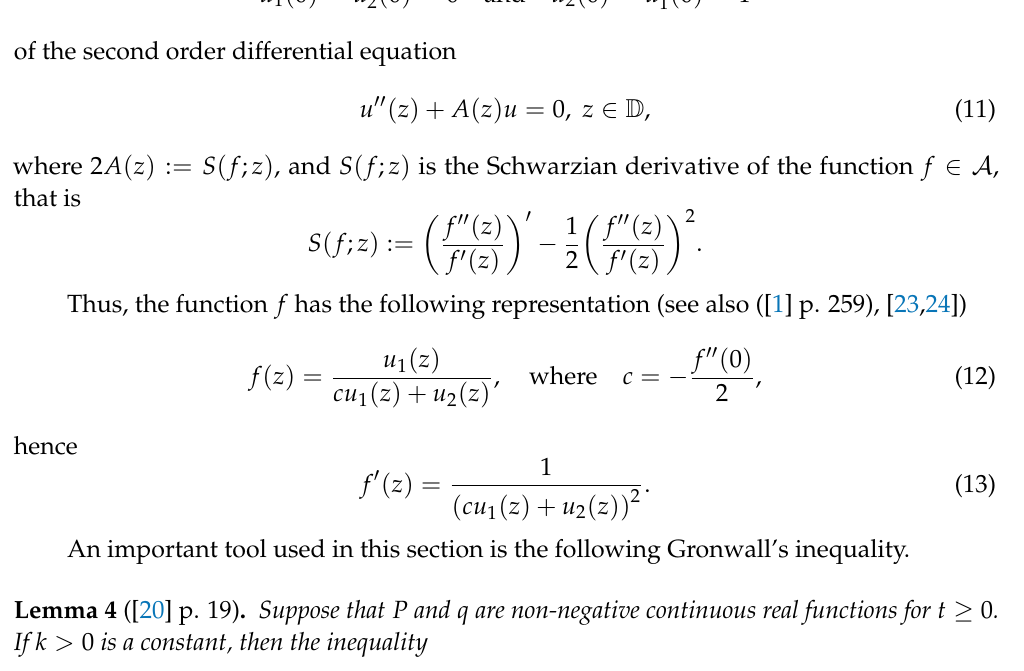
Figure 3. The graphics of v = Re R